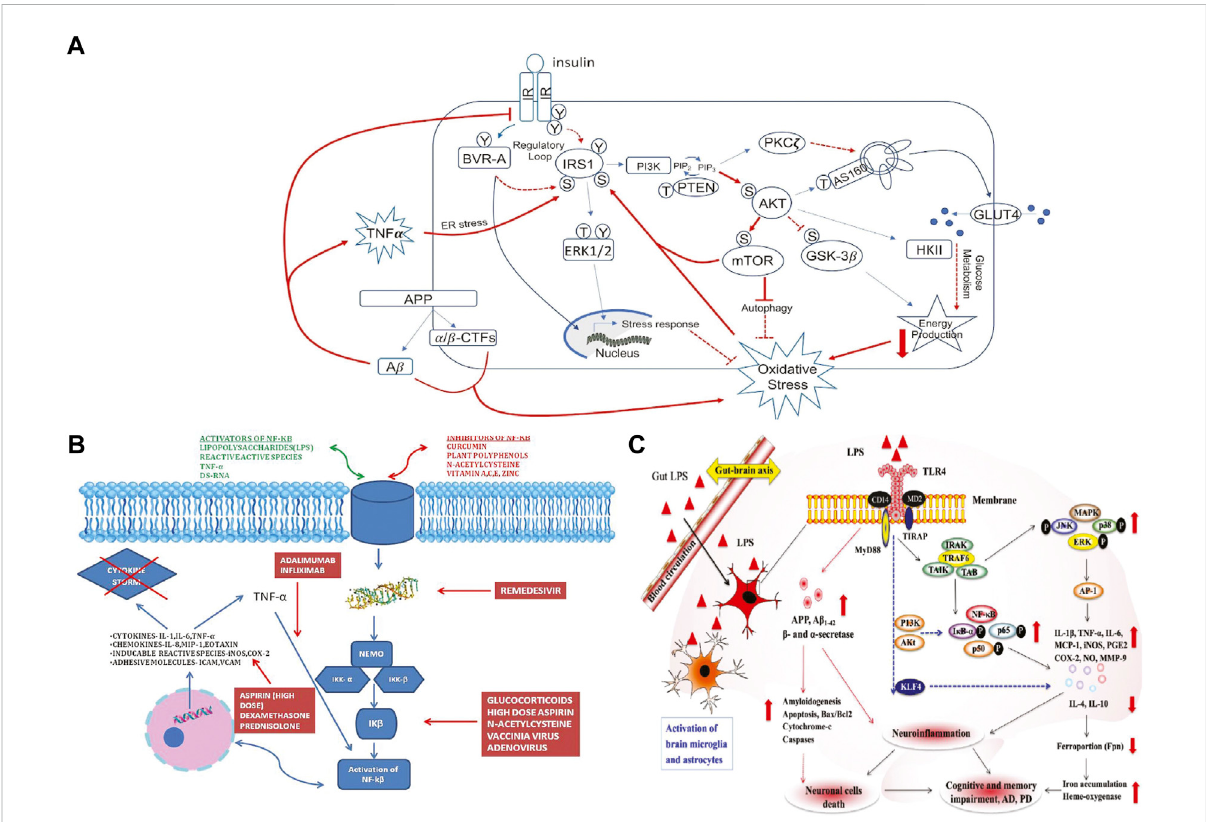
FIGURE 1 Figures selected from the literature. (A) From Figure 2 “ Schematic representation of insulin signaling with highlighted in red pathways found to promote brain insulin resistance in AD and DS. ” in (Dierssen et al., 2020). (B) From Figure 2 “ Mechanism of action of various drugs used in COVID-19 and how they inhibit the NF- κ B pathway ” in (Hariharan et al., 2021). (C) From Figure 3 “ Gut – brain axis exacerbates neurological disorders through gut-microbiota-derived molecular patterns. ” in (Suganya and Koo,